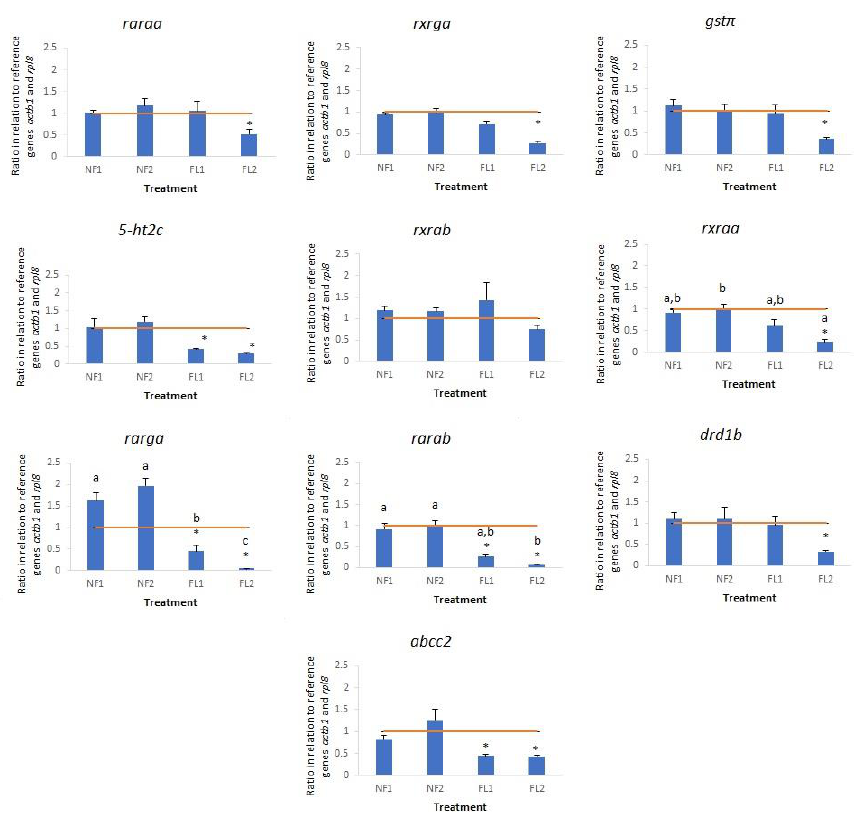
Figure 6. Relative expression of genes from cluster h. The small letters indicate the homogeneous subsets indicated by the Tukey HSD for the comparison of norfluoxetine based on MANOVA on for fold change (NF1, NF2) and fluoxetine treatments (FL1, FL2) ( p < 0.05). The stars indicate statistically significant differences ( p < 0.05) relative to the solvent control (from the results of the ANOVA on normalised expression, Table S2, Supplementary material). The horizontal line (x = 1) indicates the baseline expression for the solvent control.